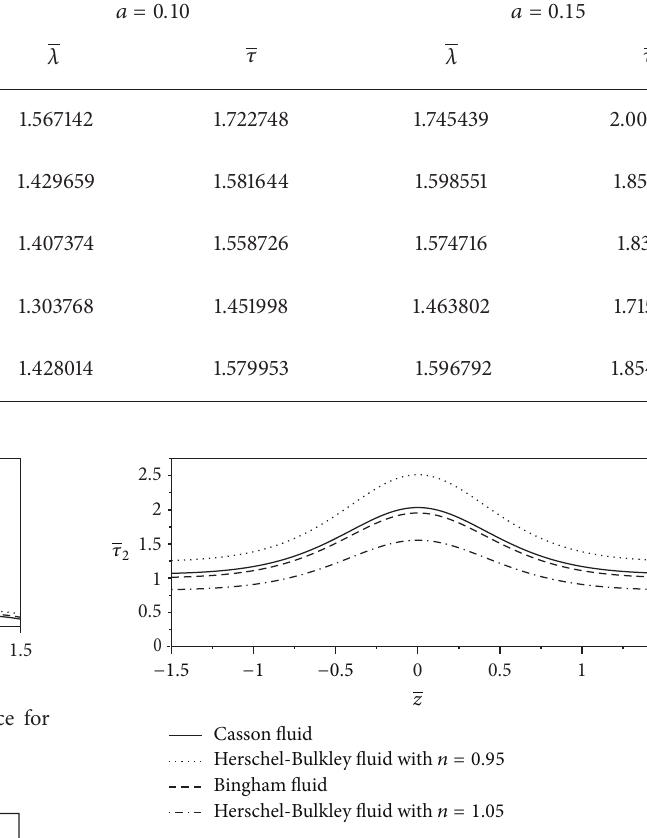
Figure 14: Variations of skin friction 𝜏 2 with axial distance for different fluid models with bell-shaped stenosis.